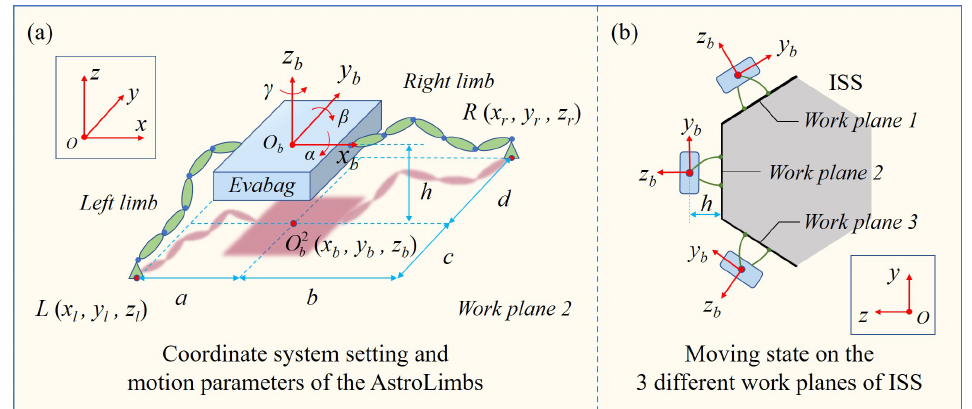
Figure 4. Simulation environment setup based in the Vrep. ( a ) Coordinate system setting and motion parameters of the AstroLimbs. ( b ) Moving state on the three different work planes of